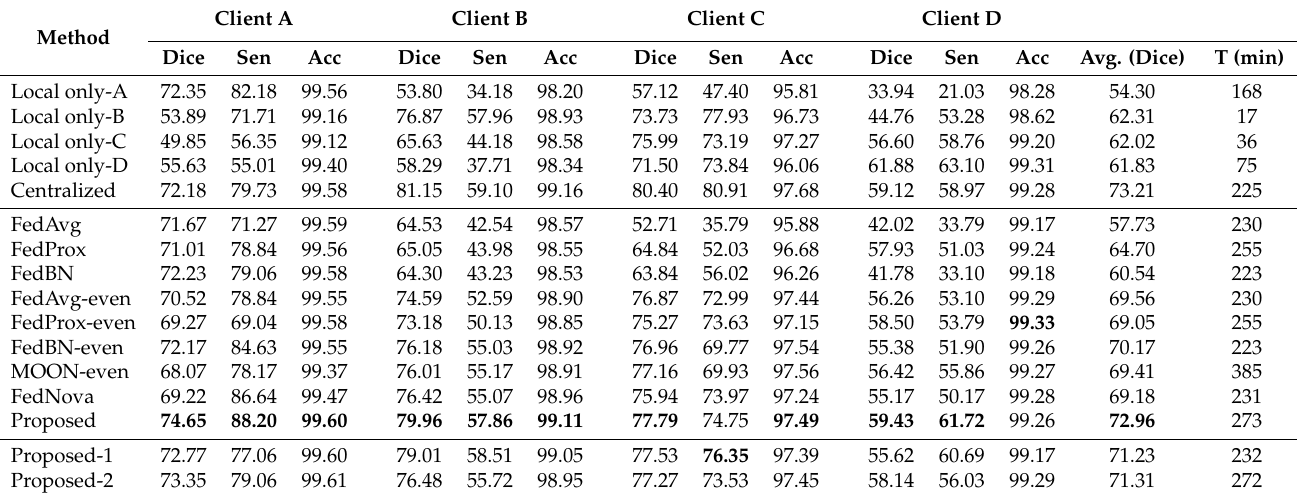
Table 1. Multi-national COVID-19 lesion segmentation. T is the total time required for model training in minutes.